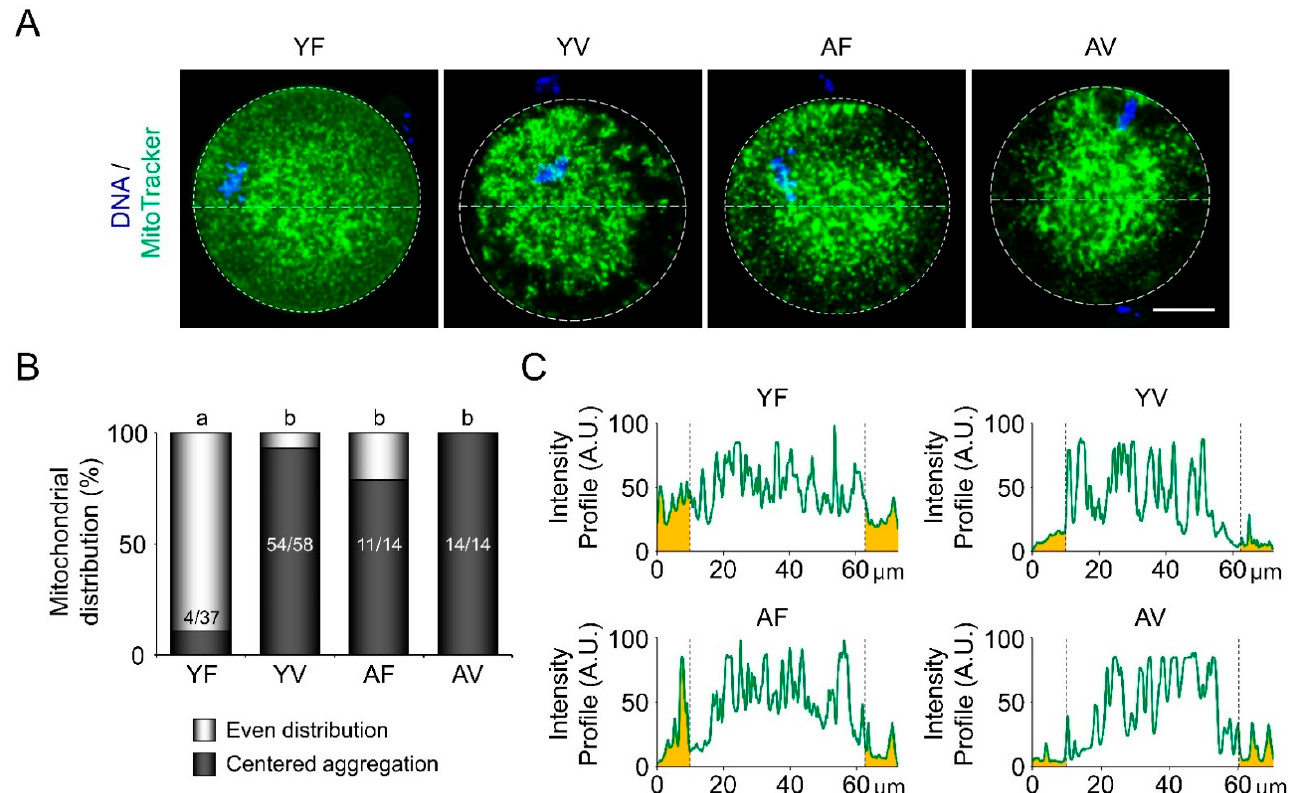
Figure 3. Fluorescence live cell imaging to examine the patterns of mitochondrial distribution after vitrification in oocytes. ( A ) Representative microscopic images of mitochondrial distribution visualized using MitoTracker dye (Green) in live oocytes from young and aged mice before or after vitrification. ( B ) Quantitative analyses of mitochondrial distribution patterns ( n = 14–58 oocytes in each group). Mitochondrial distribution was divided into even distribution and centered aggregation. White and black bars represent the percentage of even distribution and centered aggregation, respectively. ( C ) The graphs present the mitochondrial intensity profiles throughout the ooplasm of oocytes. Scale bar = 20 µ m. Statistical analyses were performed using Fisher’s exact test. Different superscript letters (a–b) denote a significant difference from the control, p < 0.05. YF: Young fresh, YV: Young vitrified, AF: Aged fresh, AV: Aged vitrified.